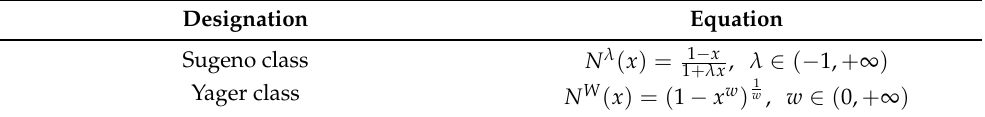
Table 3. Basic fuzzy negations